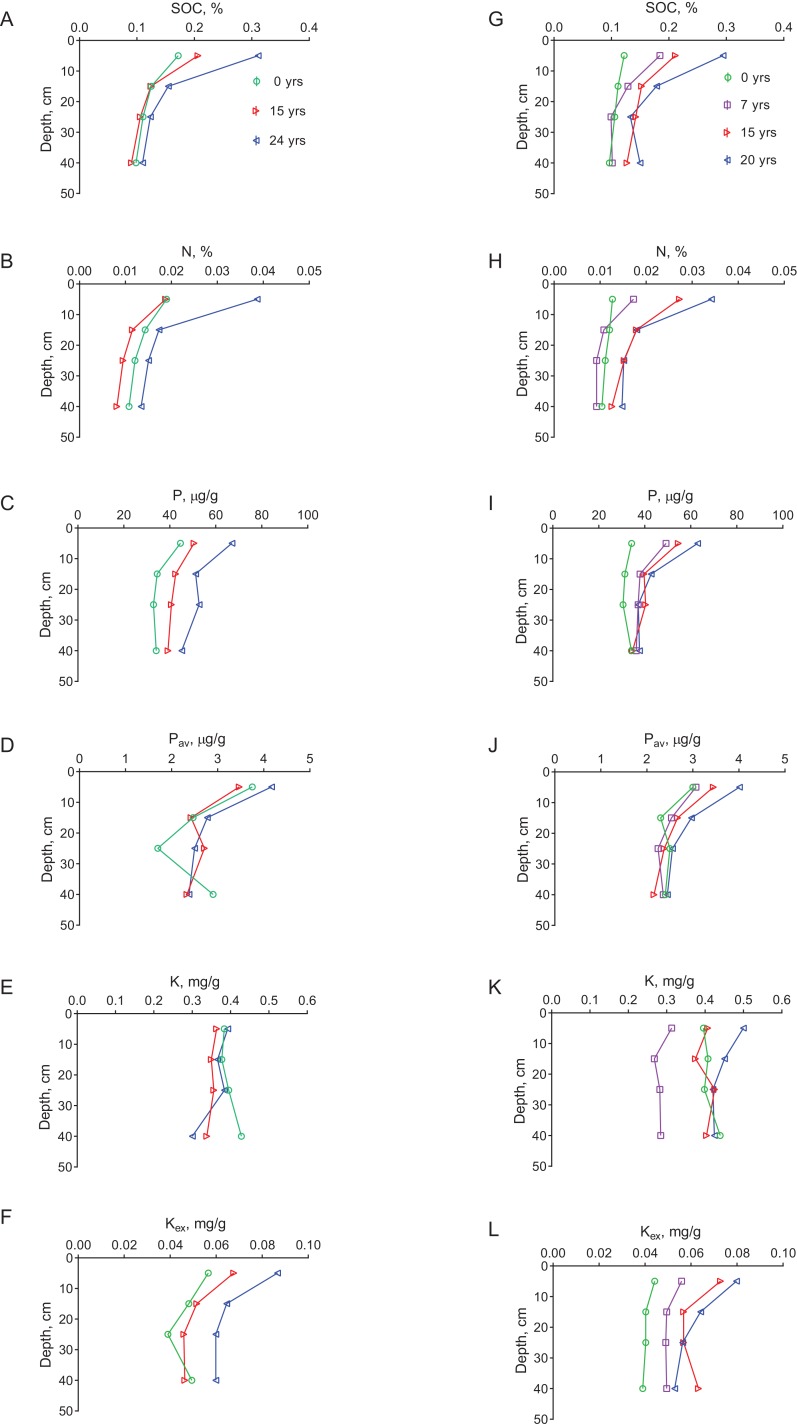
Soil SOC, N, total P, available P, total K and exchangeable K mean (n = 3) concentrations plotted against depth for grassland and plantations by age for El Demokeya (A–F) and El Hemaira (G–L) sites.SOC data from Abaker et al. (2016).